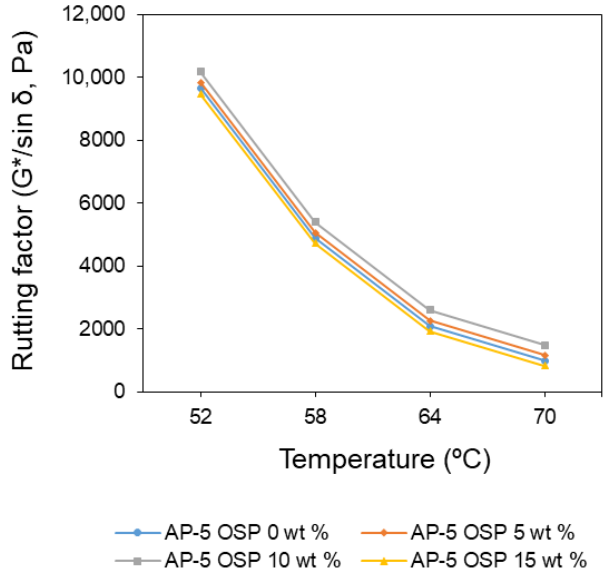
Figure 8. Effect of temperature on the rutting parameter of unfilled and OSP-filled asphalts under unaged condition.